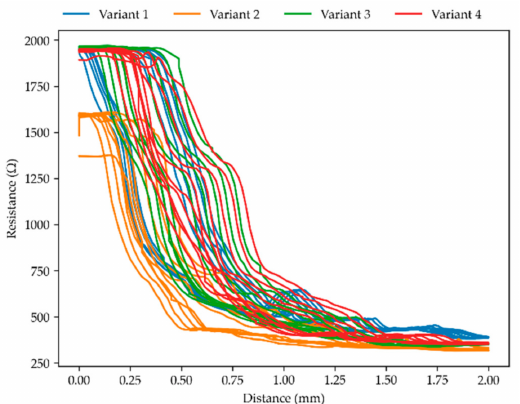
Figure 9. Resistance relation to compressed distance for measurements with a gap of 0.3 mm at 10 mm/min.